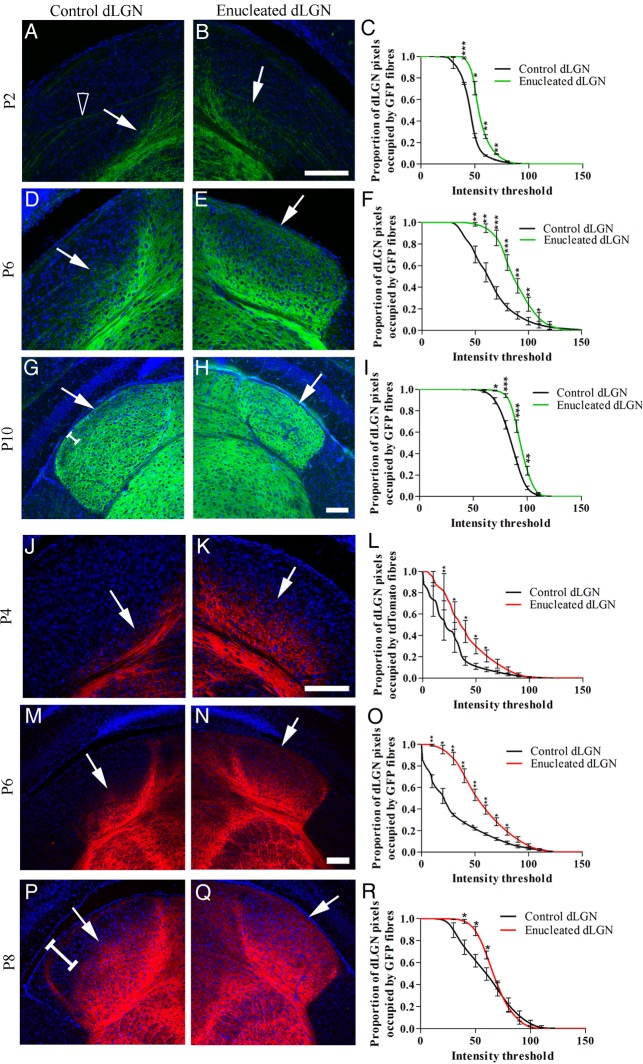
Fluorescently labeled layer VI and VIa corticothalamic fibers enter the dLGN prematurely after the removal of retinal input at birth by monocular enucleation. (A) Golli-τ-eGFP-positive VI and VIb fibers reach the ventral edge of the control dLGN by P2 (white arrow). Some eGFP-labeled fibers can be seen crossing the dLGN from the few layer V cells labeled (hollow arrow head). (B) By P2, Golli-τ-eGFP-positive VIa and VIb fibers begin to enter the enucleated dLGN (white arrow). (C) Proportionally more pixels are occupied by bright eGFP fibers in the enucleated dLGN compared with control dLGN, n = 3. (D) By P6, eGFP-positive fibers have entered the ventral half of the control dLGN (white arrow). (E) The eGFP fibers have reached the dorsal/lateral edge of the enucleated dLGN and extend throughout the nucleus (white arrow). (F) Proportionally more pixels are occupied by bright eGFP fibers in the enucleated dLGN compared with control dLGN, n = 6. (G,H) By P10, eGFP fibers have reached the dorsal/lateral edge of both the control and enucleated dLGN (white arrows); however, a less dense band remains in the control dLGN (white bracket). (I) Proportionally more pixels are occupied by bright eGFP fibers in the enucleated dLGN compared with control dLGN though the difference is less substantial, n = 5. (J) At P4, layer VI Ntsr1-Cre::tdTomato fibers have reached the ventral edge of the control dLGN, but do not yet enter (white arrow). (K) Layer VI Ntsr1-Cre::tdTomato fibers have entered the ventral half of the enucleated dLGN (white arrow). (L) Proportionally more pixels are occupied by bright tdTomato fibers in the enucleated dLGN compared with control, n = 3. (M) By P6, Ntsr1-Cre::tdTomato-positive layer VIa fibers have entered the ventral half of the control dLGN (white arrow). (N) Layer VIa tdTomato-labeled fibers have reached the dorsal/lateral edge of the enucleated dLGN (white arrow). (O) Proportionally more pixels are occupied by bright tdTomato fibers in the enucleated dLGN compared with control dLGN, the difference is greatest at this age, n = 4. (P) By P8, tdTomato fibers do not yet reach the dorsal/lateral edge of the control dLGN (white arrow and white bracket). (Q) The fibers are more densely arborized throughout the enucleated dLGN, but are not yet evenly distributed. (R) There are proportionally more pixels occupied by bright tdTomato-positive fibers in the control dLGN compared with the enucleated dLGN at P8, n = 4. Values on graphs are mean and standard error. Scale bars = 50 µm A–E, G–H, I–J, M–Q.